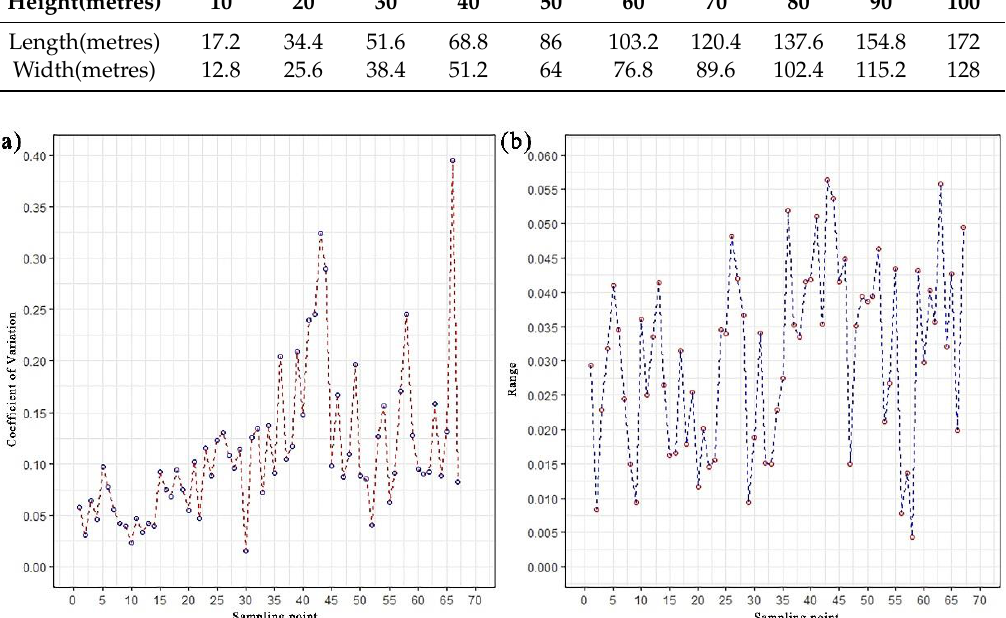
Figure 5. Impact of scale on extracting FVC: ( a ) the change in the coefficient of variation, and ( b ) the range of FVC extracted from 10 photos taken at 10–100 metres above each sample point.